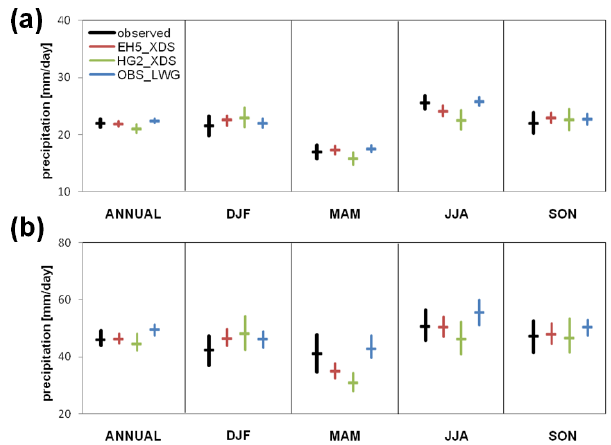
Fig. 4. (a) 90th and (b) 99th percentiles of observation (1971–2000) and reference simulations (EH5 XDS, HG2 XDS, OBS LWG; Figure 4: (a) 90-% and (b) 99-% percentiles of observation (1971-2000) and reference 3 1971–2000). Vertical lines indicate 90% bootstrap confidence in- simulations (EH5_XDS, HG2_XDS, OBS_LWG; 1971-2000). Vertical lines indicate 90-% 4 tervals. 24-h precipitation events averaged over the Lech catchment are shown. Fig. 5. (a) 5-yr and (b) 20-yr return values for observation bootstrap confidence intervals. 24-h precipitation events averaged over the Lech catchment 5 are shown. 6